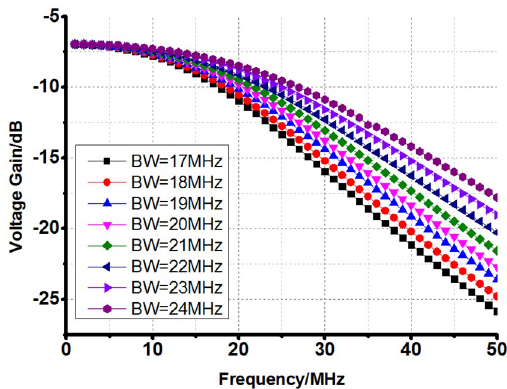
Figure 15. Measured frequency tuning response of the LPF (1 stage third-order LPF).